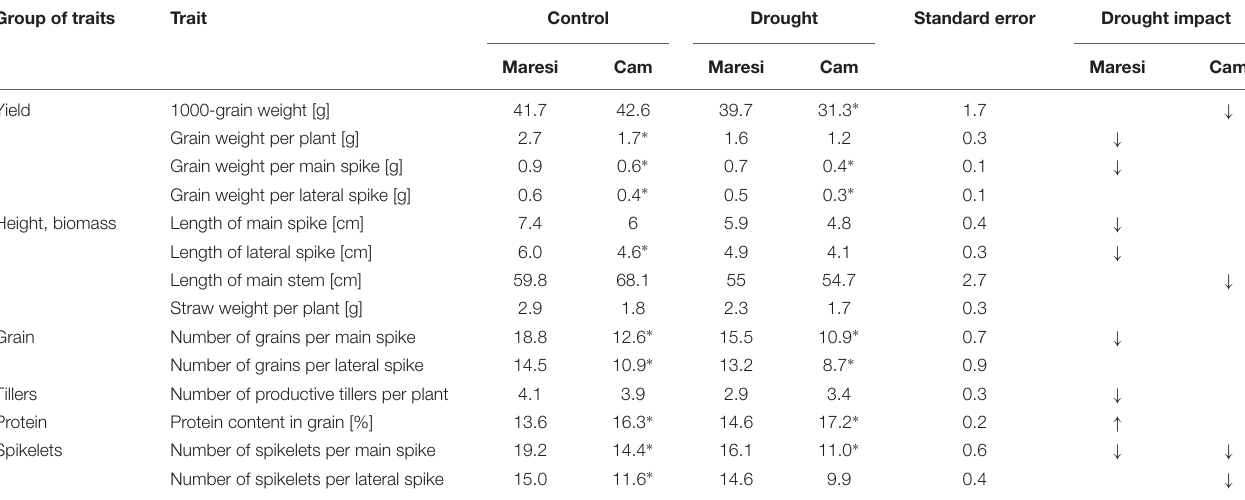
TABLE 1 | Drought induced changes in phenotypic traits observed in mature barley plants. Group of traits Trait Control Drought Standard error Drought impact